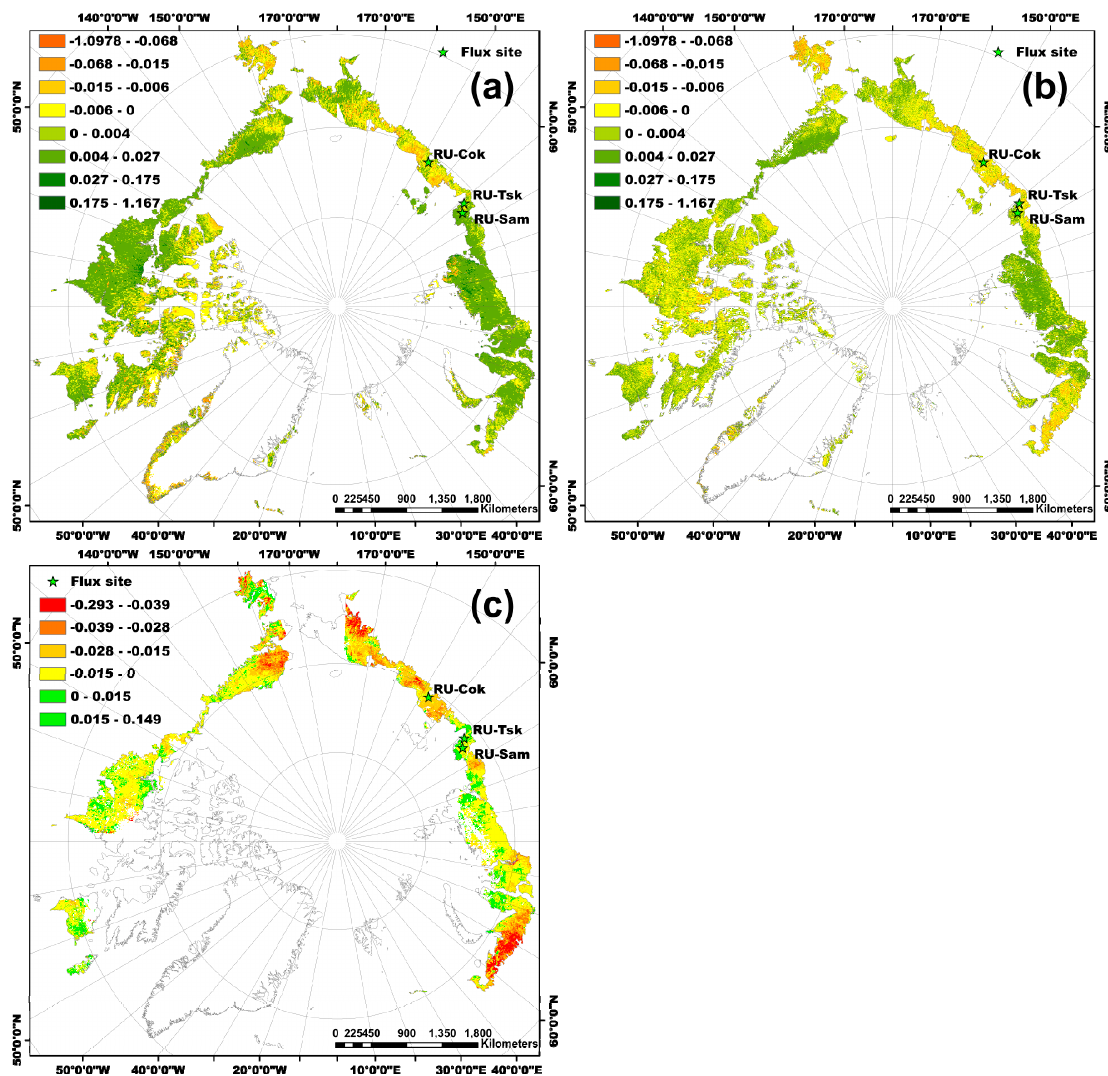
Figure 2. Spatial patterns of the Arctic tundra greenness (annual maximum value) trend from 2007 to 2013. ( a ) GIMMS NDVI3g, ( b ) MOD13Q1, and ( c ) SIF (unit: mW/m 2 /sr/nm/year). The green colors represent the tundra greening, while the yellow, brown, and red colors represent the tundra browning.